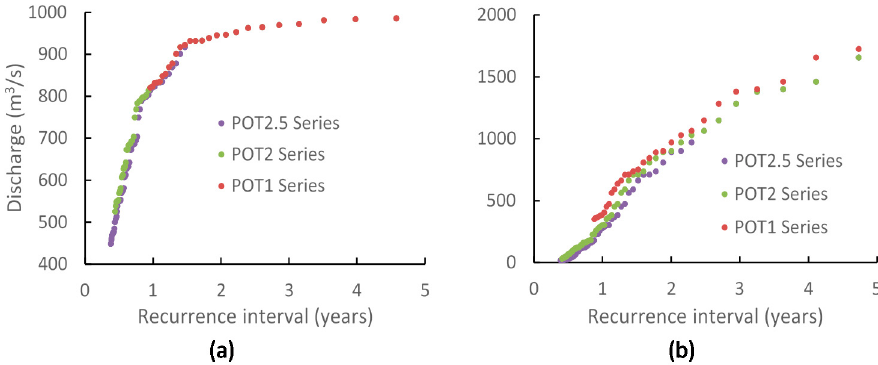
Figure 5. Comparison of flood magnitude under a given recurrence interval for three POT series for ( a )